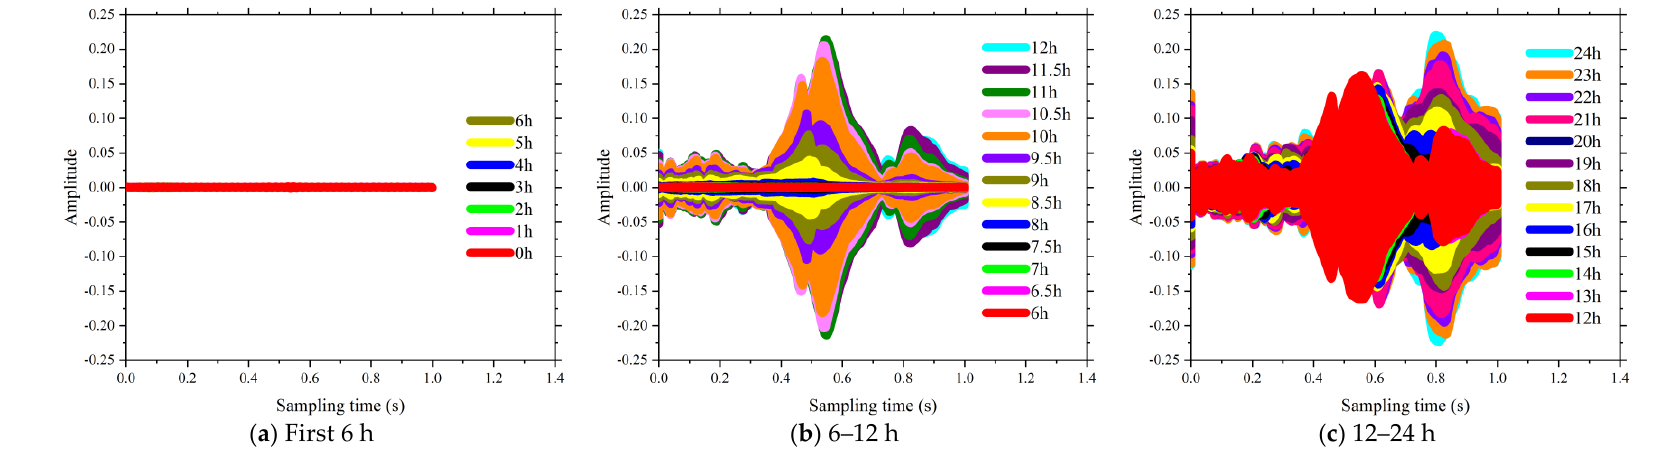
Figure 14. Influence of volume of fly ash on the signal amplitude at hydration monitoring (FA-20%).